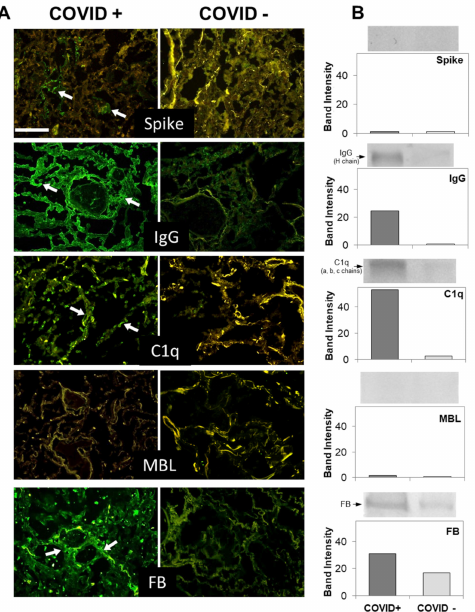
Figure 1. ( A ) Detection of spike and complement components in lung sections by immunofluo- rescence analysis. The panel shows representative immunofluorescence images obtained from the analysis of several sections of lung autopsy samples from 12 SARS-CoV-2-positive and 3 negative cases. The sections were stained to reveal the presence of spike protein, IgG, MBL, C1q, and Factor B (FB) (highlighted by a white arrow), as explained in materials and methods, and examined by three independent observers. Scale bar = 50 µ m. ( B ) Evaluation of spike and complement components by western blot in the lungs of a COVID+ and a COVID − patients. The columns represent the staining intensity of the western blot bands quantified using ImageJ (Fuji-NIH). Western blot bands of spike protein, IgG, C1q, MBL and FB are shown on top of the corresponding